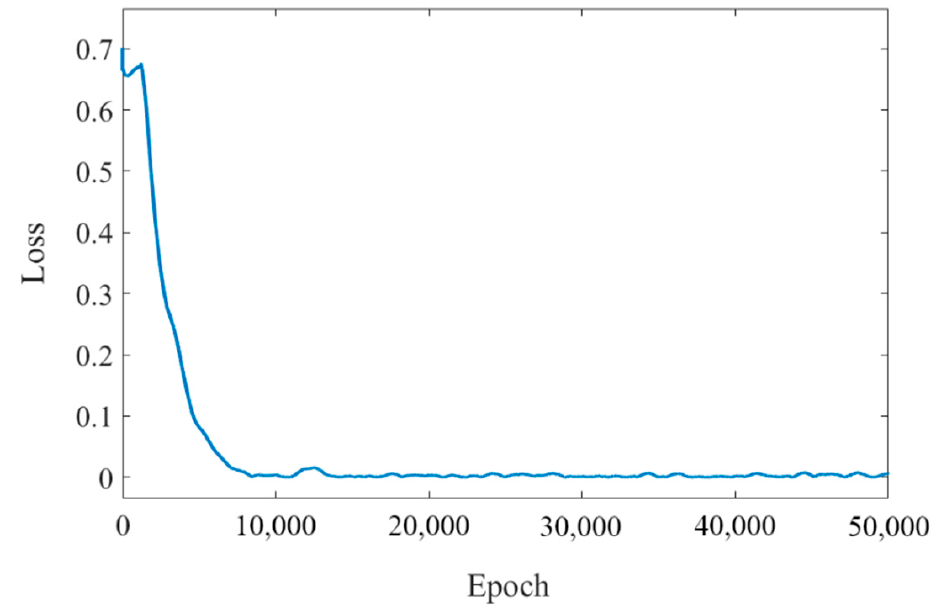
Figure 13. Step response curves of the three controllers under model mismatch.